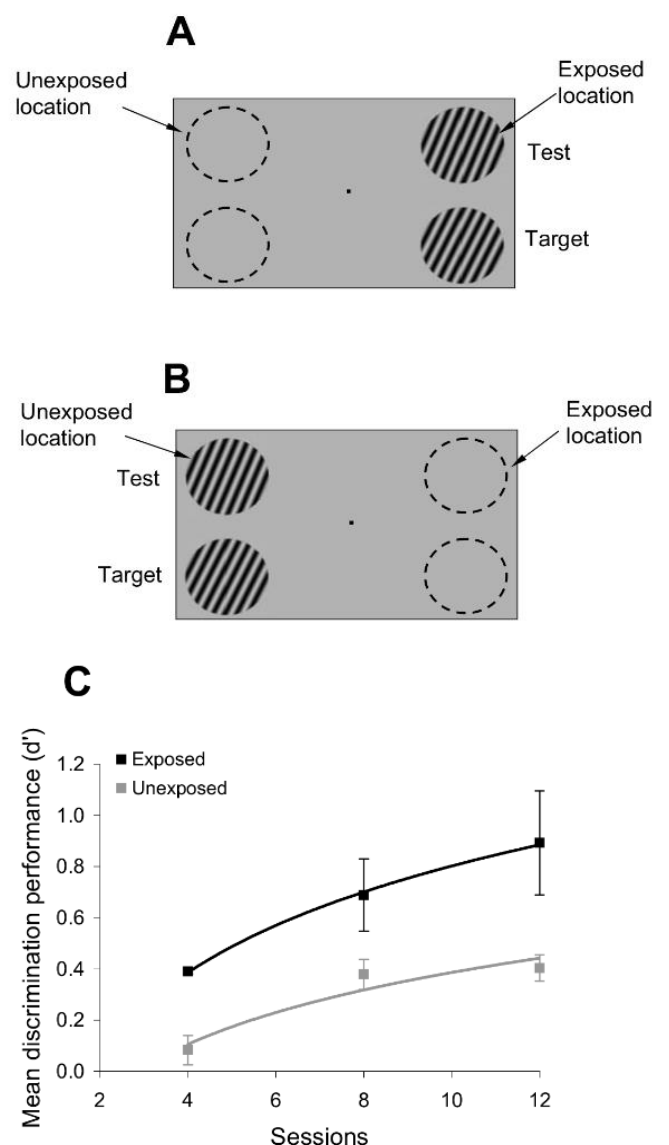
Figure 5. Simultaneous orientation discrimination. ( A , B ) Orientation discrimination performance was measured at both the exposed ( A ) and unexposed ( B ) locations by simultaneously presenting the test and target stimuli. The test was always presented at a fixed location (above the unexposed location). The center-to-center distance between the target and test locations was 5°. Each discrimination test was conducted after an exposure session similar to that discussed in Figure 1. ( C ) Exposure to orthogonal orientations significantly alters simultaneous orientation discrimination performance at the exposed location.